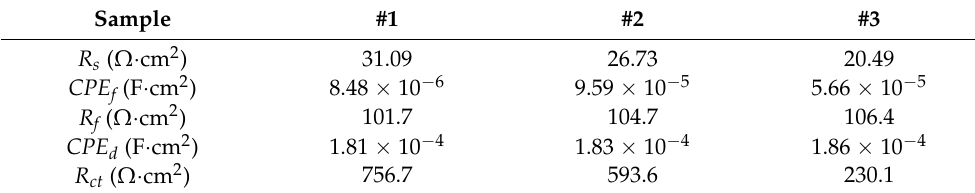
Table 5. Equivalent circuit parameters.